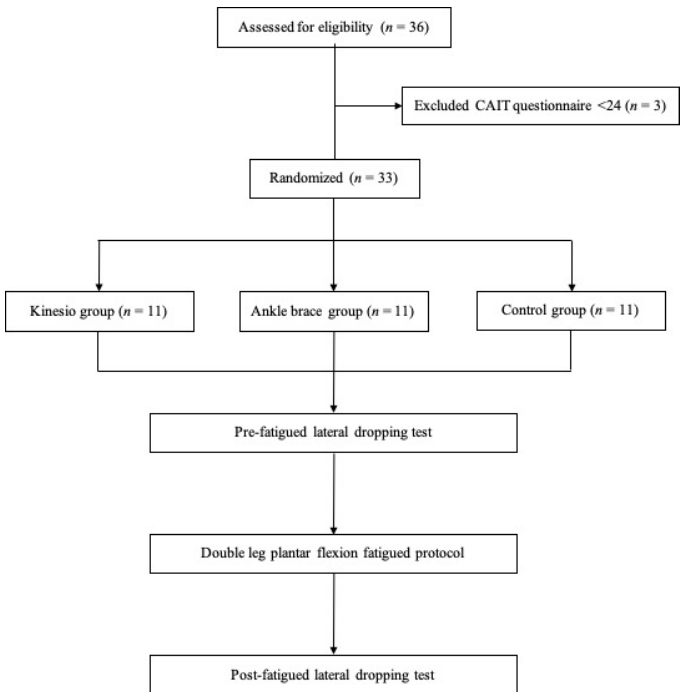
Figure 1. Flow chart of the experimental test procedure for the control (Cn), ankle brace (AB), and kinesio tape (KT) groups.